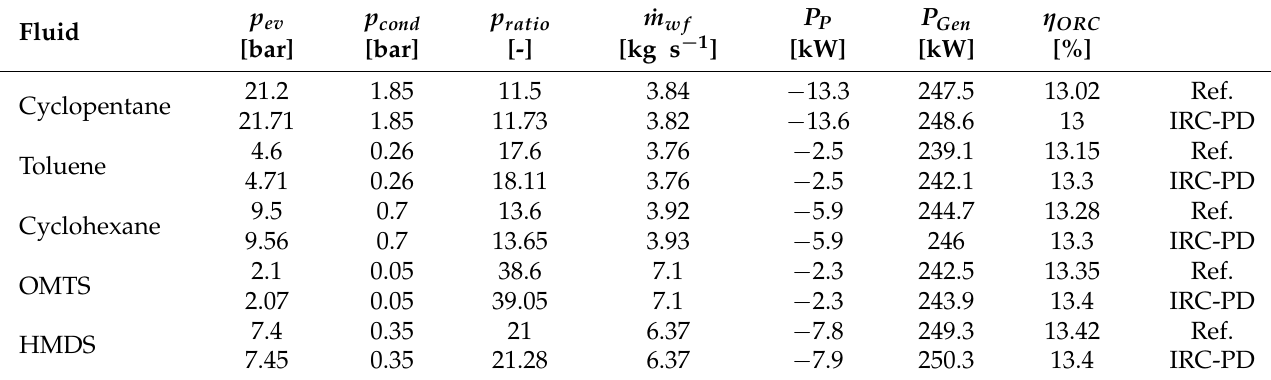
Table 3. Comparisons between the results obtained by the IRC-PD tool and the ones listed in ref. [35]. Fluid